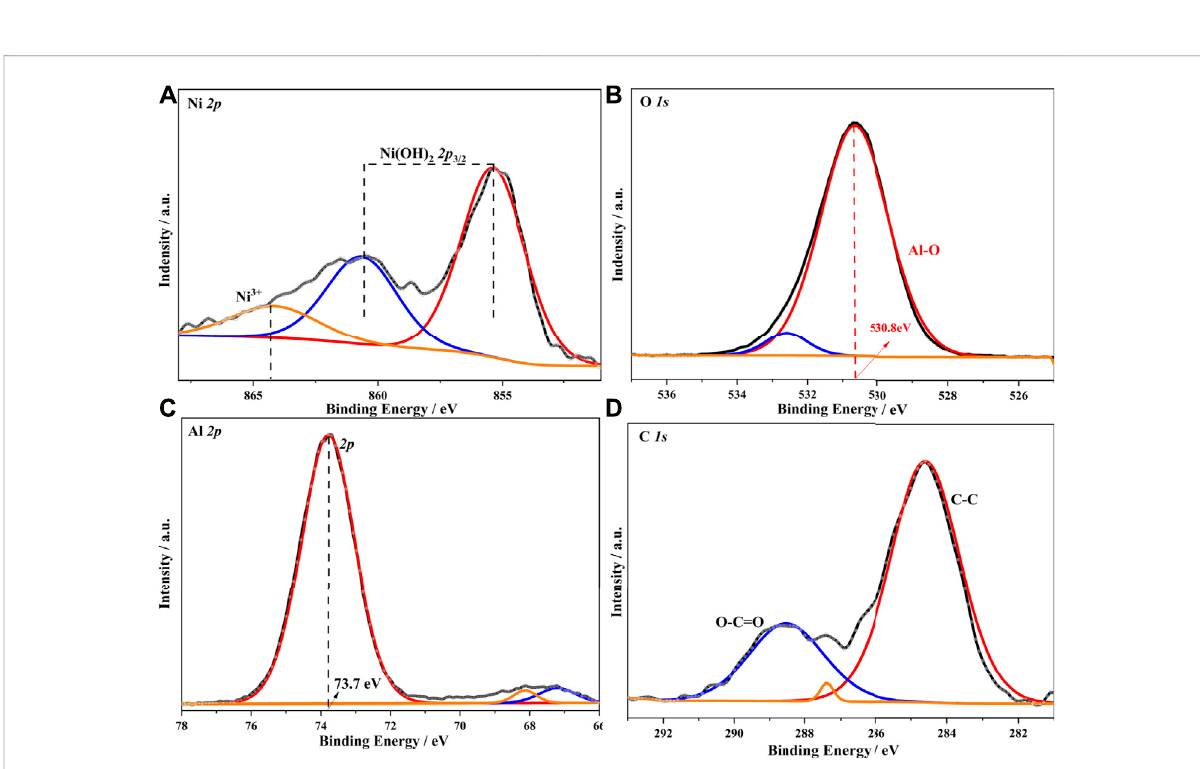
FIGURE 4 Partial binding energy spectra of α -Ni(OH) 2 /Al 2 O 3 composite: (A) α -Ni(OH) 2 /Al 2 O 3 Ni 2 p, (B) α -Ni(OH) 2 /Al 2 O 3 O 1 s, (C) α -Ni(OH) 2 /Al 2 O 3 Al 2 p, and (D) α -Ni(OH) 2 /Al 2 O 3 C 1